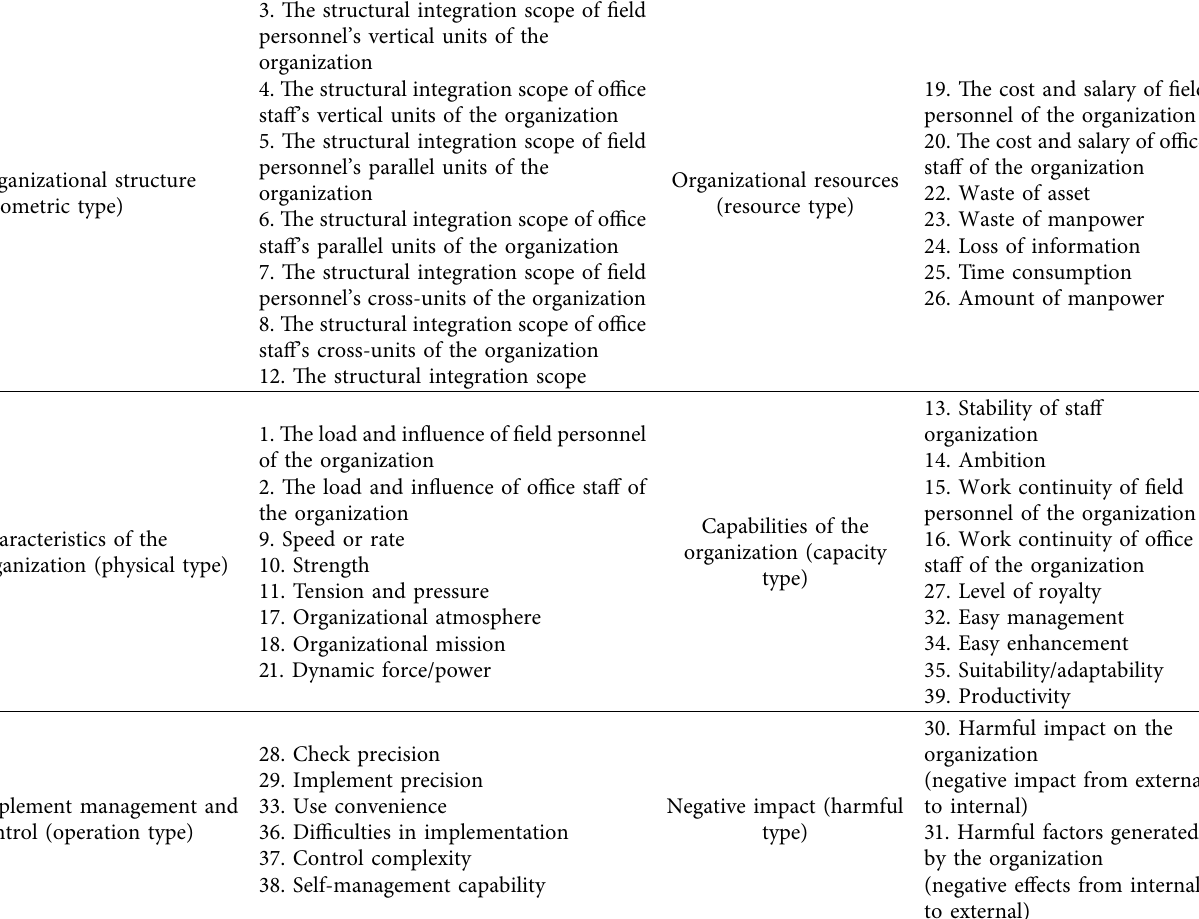
Table 2: Initial definition of 39 features used by interface-related contradiction